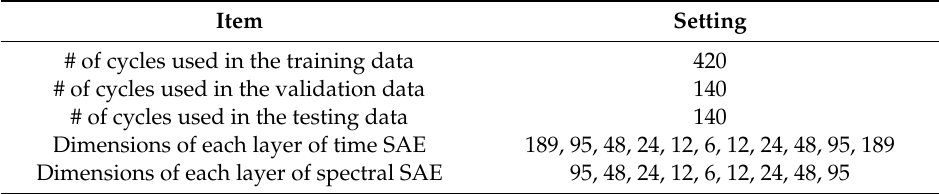
Table 7. The experiment settings for the experiment in Section 6.2.